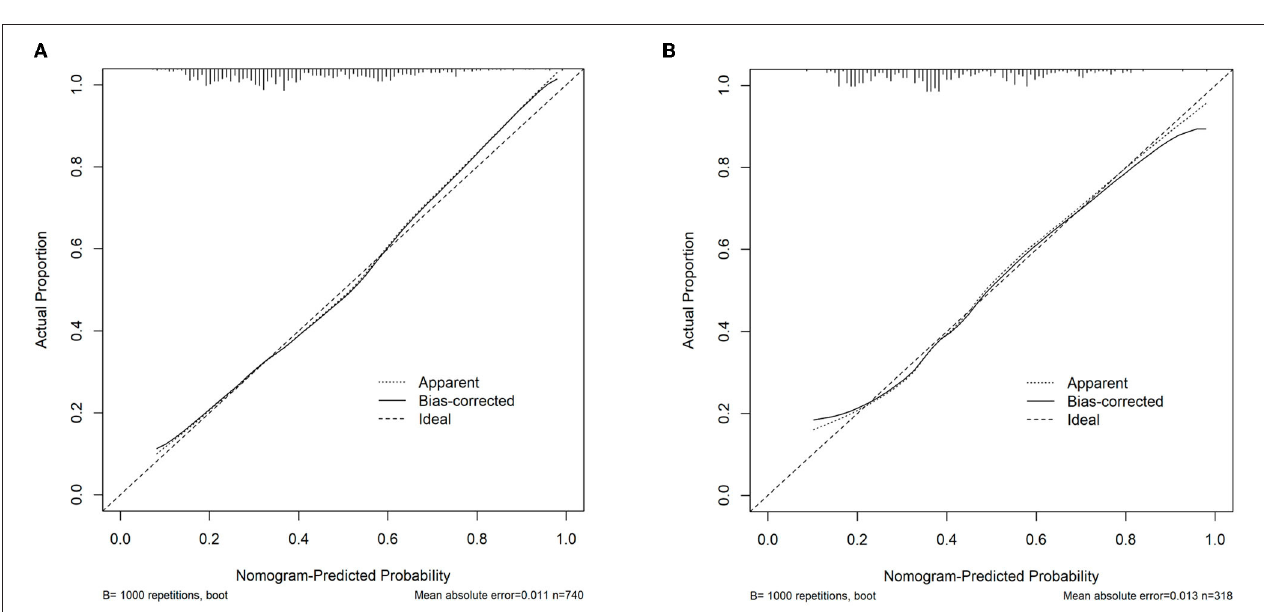
FIGURE 3 | The performance of the nomogram model for predicting MVI by receiver operating characteristic (ROC) curve. (A) ROC curve in the training cohort. (B) ROC curve in the validation cohort.